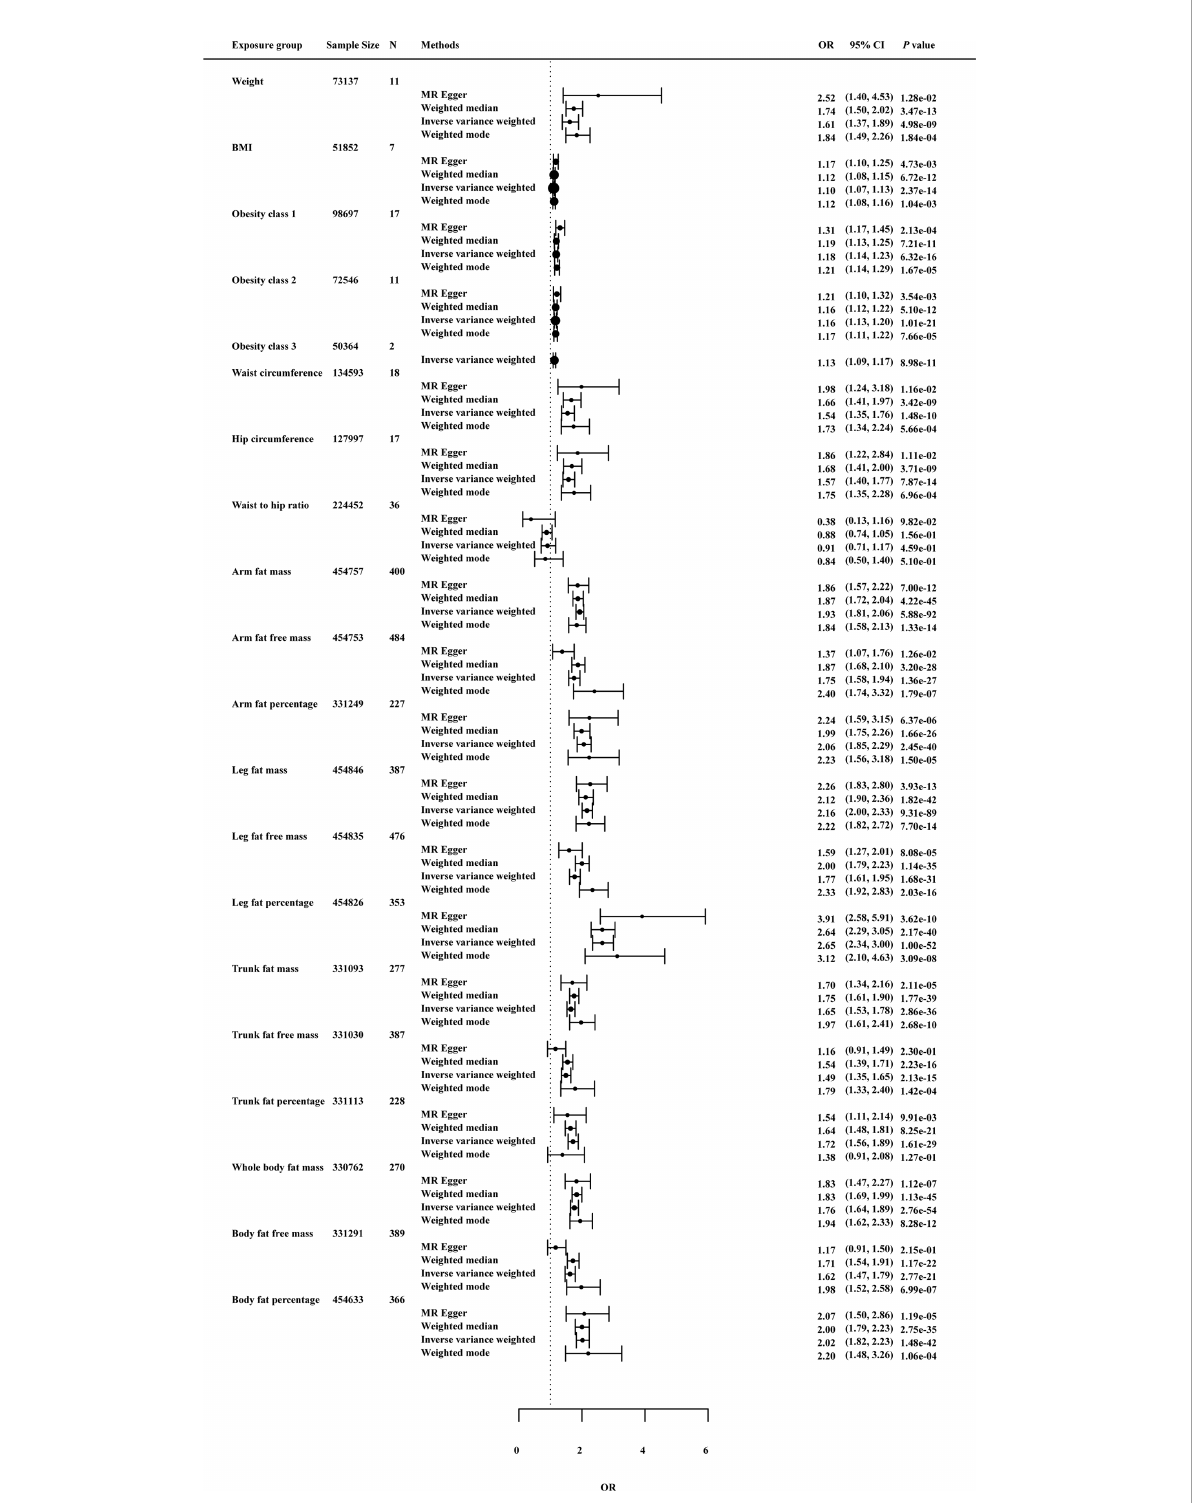
FIGURE 5 Effects of obesity-related exposures on knee or hip OA. Results from univariable MR analyses showing the effects of genetic predicted obesity related anthropometric indicators and body compositions on knee or hip OA with IVW, MR-Egger, weighted median, and weighted mode